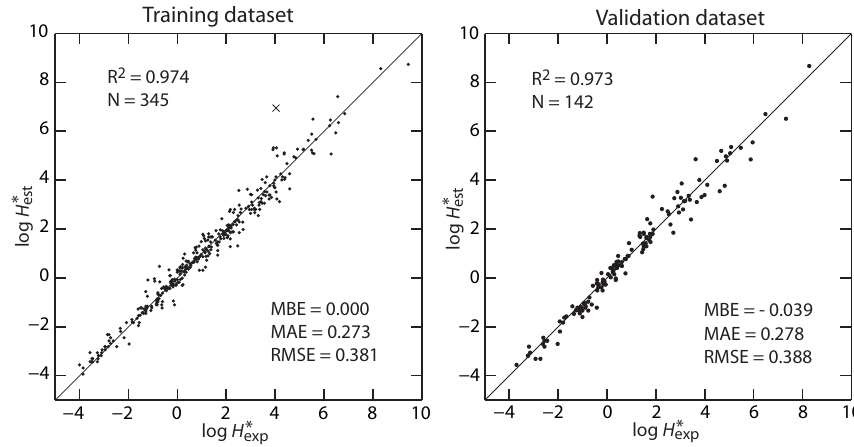
Fig. 2. Scatter plot of estimated log H ∗ using GROMHE versus experimental log H ∗ for the training set (left panel) and the validation set (right panel). The line is the y = x line. The ( x ) symbol represents oxo-acetic